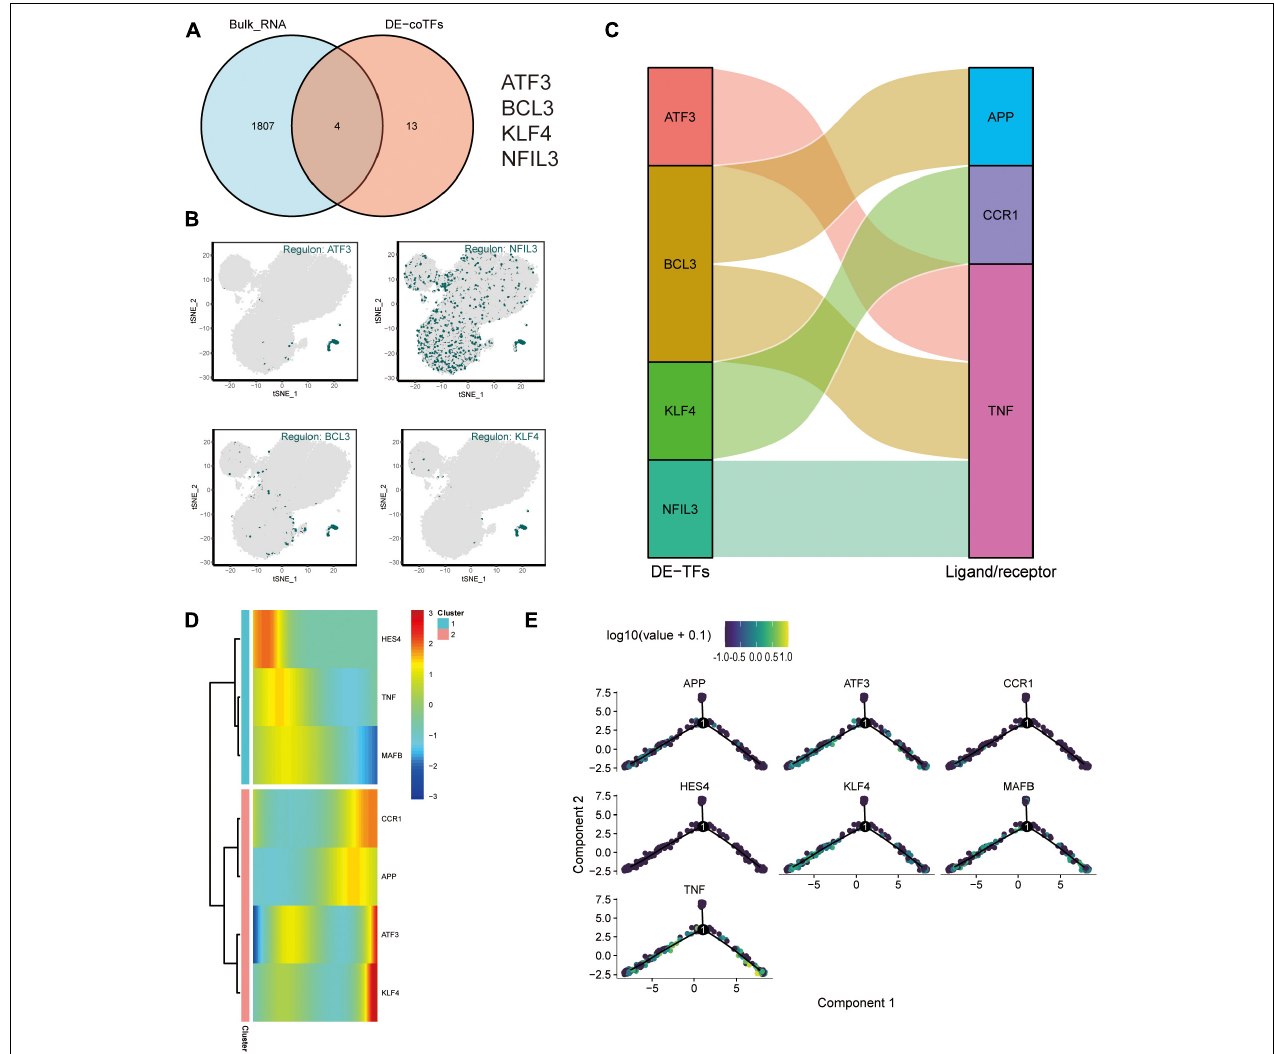
FIGURE 7 | Exercise regulates AD monocyte transcription (ERADMT) gene sets. (A) Intersection analysis of 17 key transcription factors from the M4 cluster with 1811 DEGs after exercise; (B) Expression characteristics of the intersecting genes ATF3 , NFIL3 , BCL3 , and KLF4 on the t-SNE plot; (C) Sangi diagram showing the key ligands or receptors (including: APP , CCR1 , and TNF ) that may be regulated by the co-differentially expressed transcription factors (including: ATF3 , BCL3 , KLF4 , and NFIL3 ); (D) Heat map indicating the relationship between APP , CCR1 , TNF , ATF3 , KLF4 , HES4 , and MAFB expression and pseudo-time; (E) Expression characteristics of APP , CCR1 , TNF , ATF3 , KLF4 , HES4 , and MAFB on the pseudotime